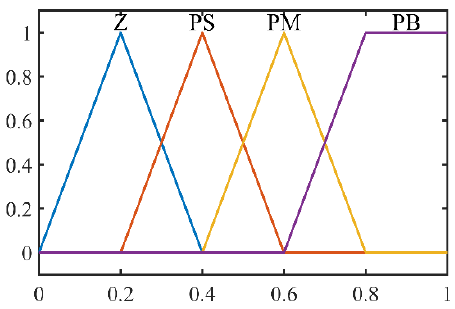
Figure 6. Membership functions of ( a ) estimated speed (cid:2033)(cid:3549) and ( b ) speed error (cid:1857) = (cid:2033) − (cid:2033)(cid:3549) .